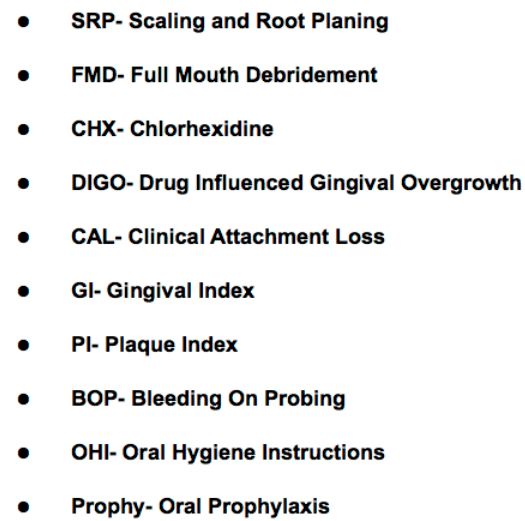
Figure 2. Schematic Guideline for Treatment of CCB- Influenced Gingival Enlargement.